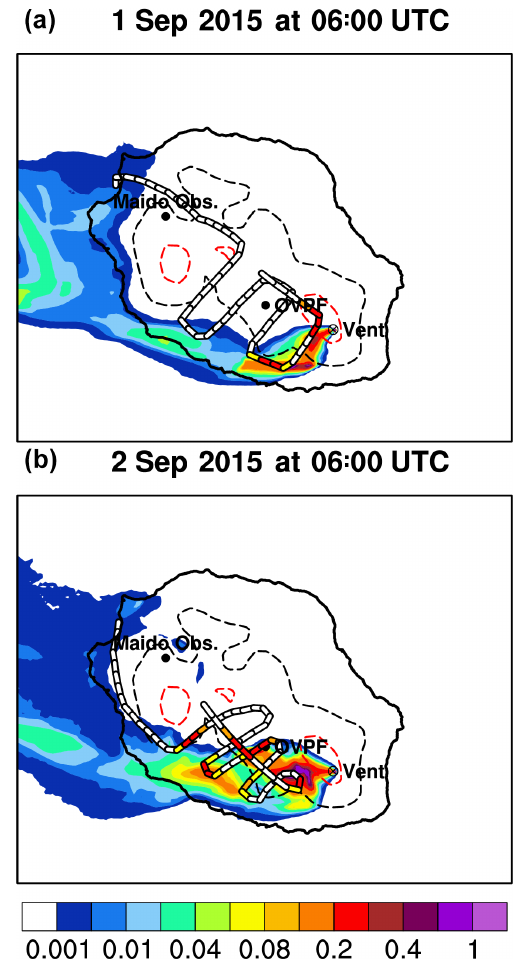
Figure 11. Relative mixing ratio of the tracer load emitted at the vent and simulated by FLEXPART on 1 September 2015 (a) and on 2 September 2015 (b) . The flight path is coloured as a function of the measured SO 2 mixing ratio (white for less than 100ppb, yellow between 100 and 200ppb, orange between 200 and 400ppb and red for more than 400ppb). The dotted lines show the 1000 (black) and 2000ma.s.l. (red)